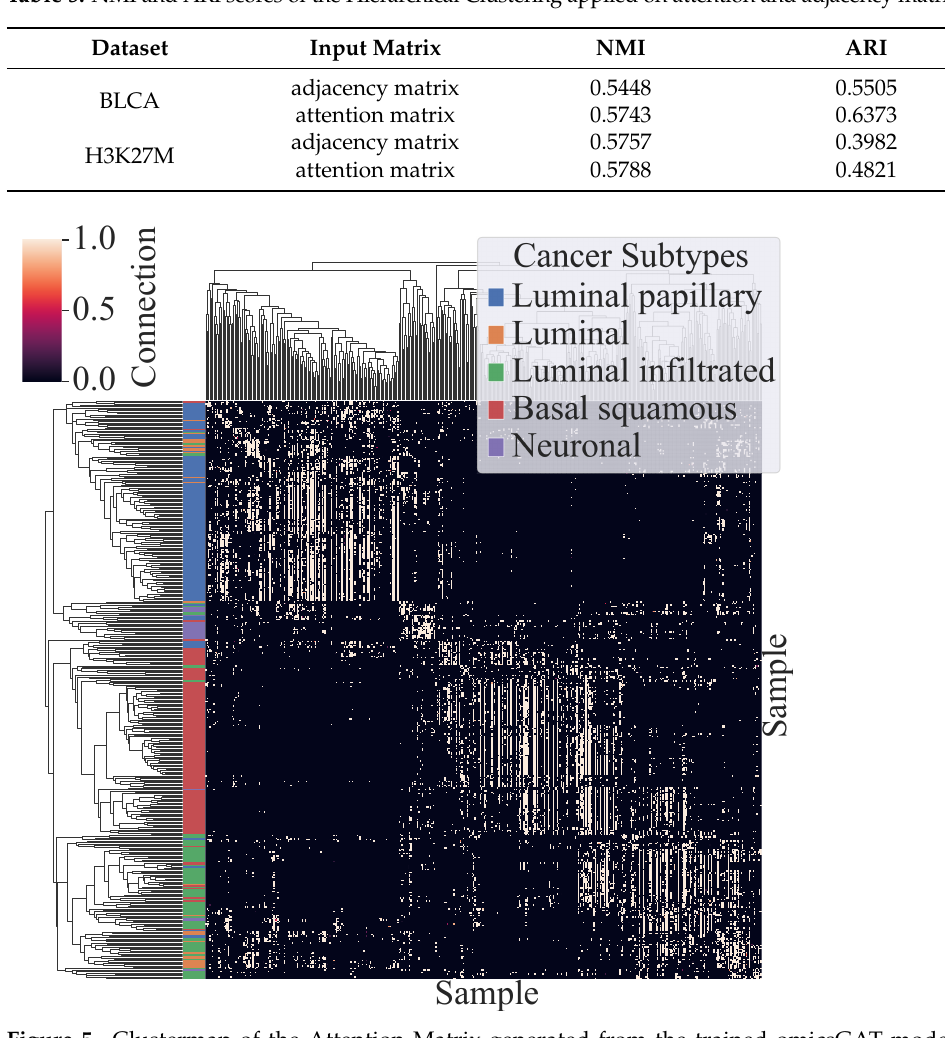
Figure 5. Clustermap of the Attention Matrix generated from the trained omicsGAT model on BLCA